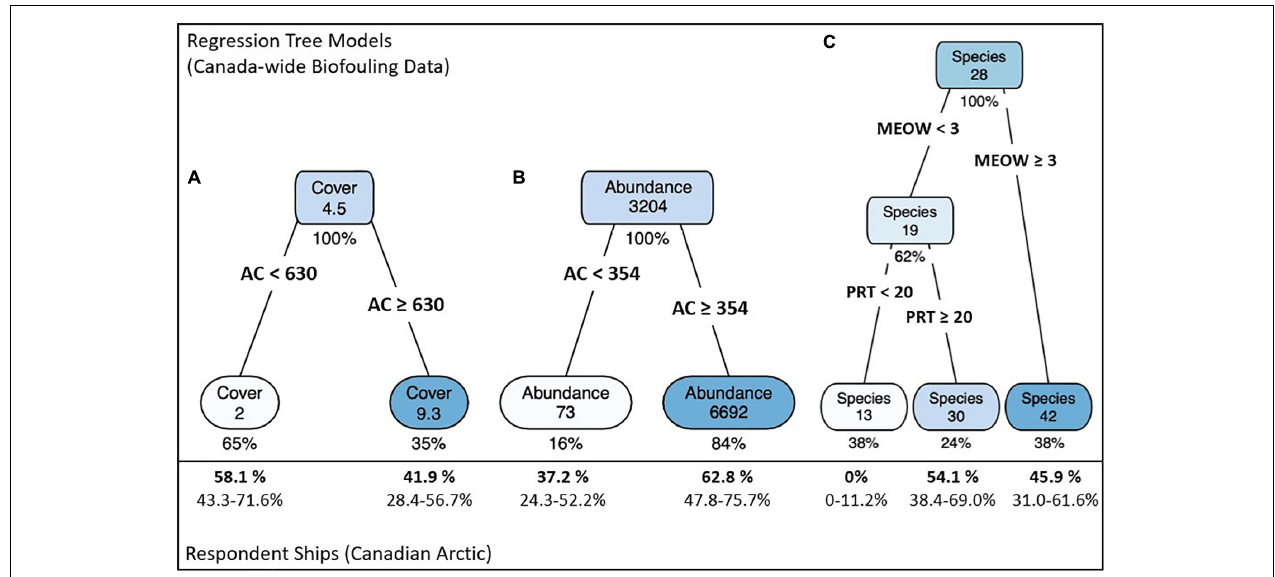
FIGURE 3 | Regression trees for predicting the percent cover of biofouling (A) , total abundance of fouling invertebrates [log 10 (x + 1) transformed] (B) , and fouling species richness (C) on commercial ships, based on 53 commercial ships arriving at Halifax, NS, Vancouver, BC, and Churchill, MB. The measured predictors of biofouling extent were age (days) of antifouling coating system (AC), total port residence time over the last 10 ports-of-call (PRT), and number of Marine Ecoregions of the World biogeographic realms (MEOW) visited over the last 10 ports-of-call. The proportion of respondent Canadian Arctic ships that fall under each terminal node of the regression tree models, based on questionnaire data, are shown in the lower box in bold, with 95% Agresti-Coull binomial confidence